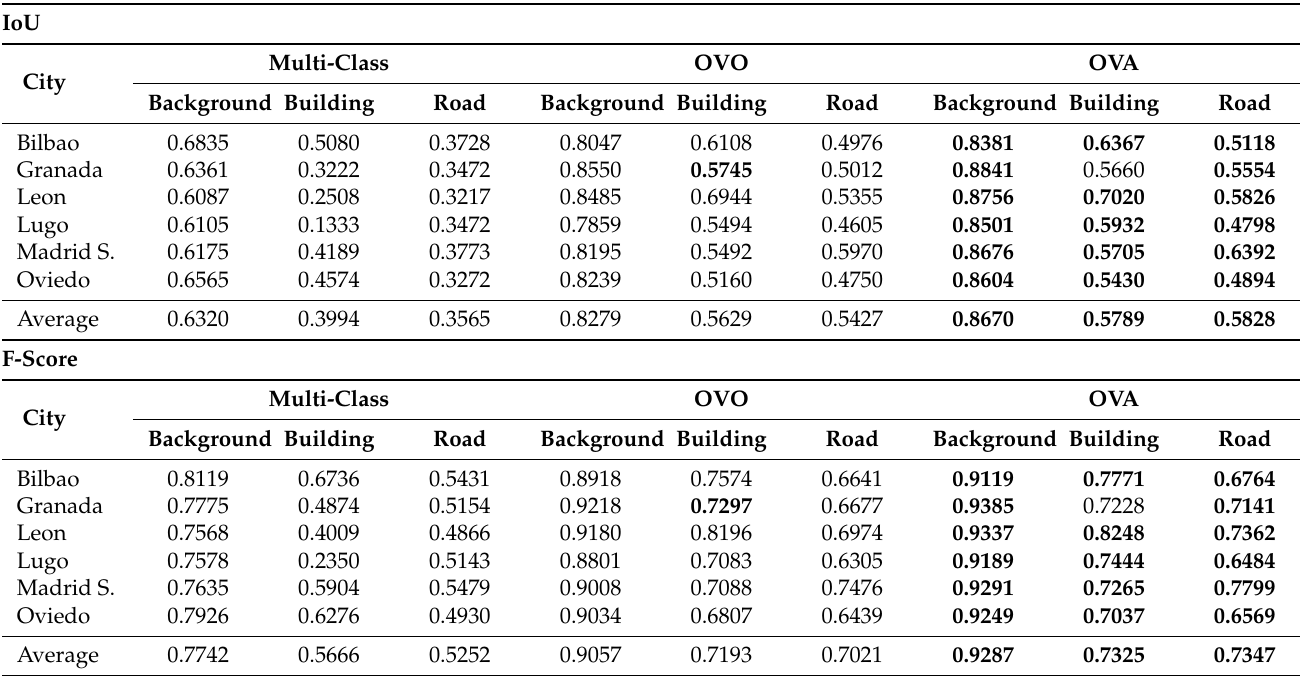
Table 2. Results obtained in terms of averaged IoU and F-score metrics, in the testing set for Experiment 1.